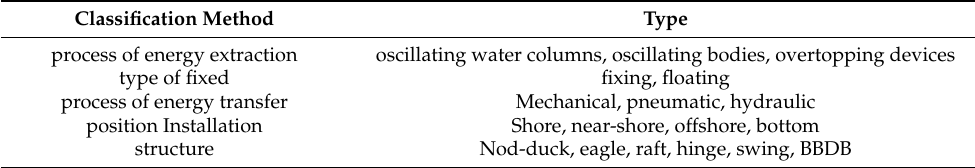
Table 1. Classification of